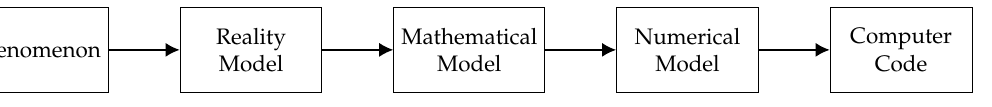
Figure 5. Classical model building process (from